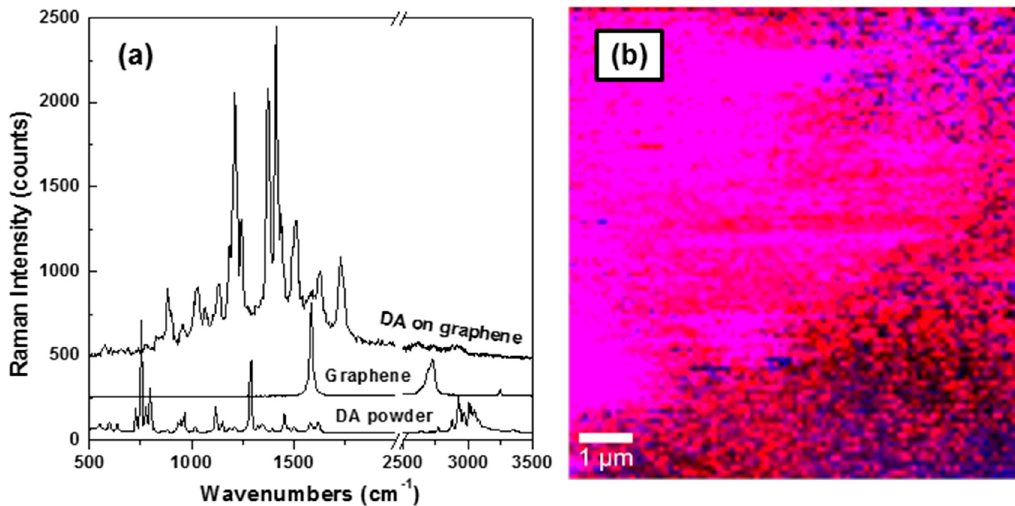
Figure 5. ( a ) Representative Raman spectra of standard dopamine powder, graphene and dopamine detected on a graphene surface, as labeled; ( b ) Confocal Raman mapping of dopamine ( red ) and graphene ( blue ). Magenta color is a combination of red and blue indicating the presence of both materials.